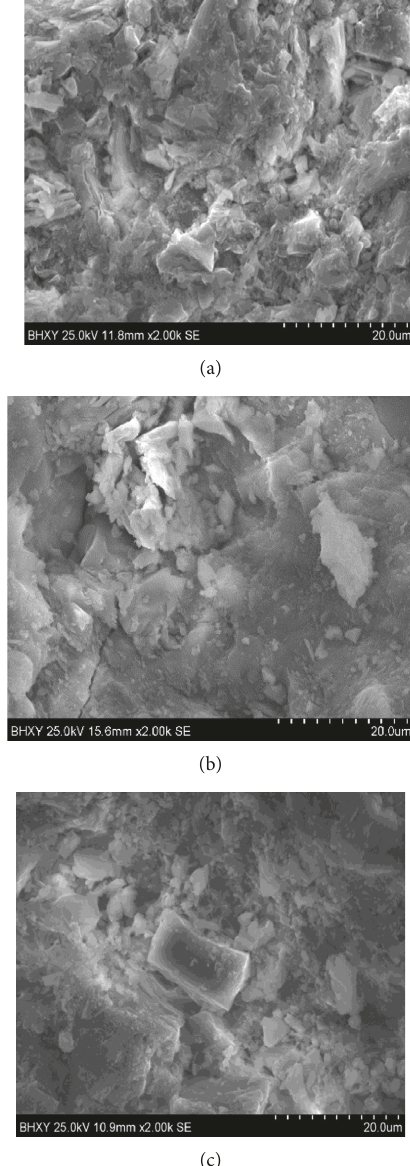
Figure 6: SEM images in different interfacial transition zones before carbonization: (a) LG-LJ interface; (b) LG-XJ interface; (c) LJ-XJ